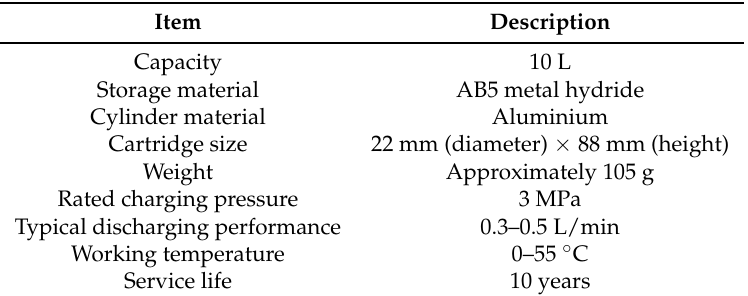
Table 2. Hydrostick Pro metal hydride fuel stick specifications.